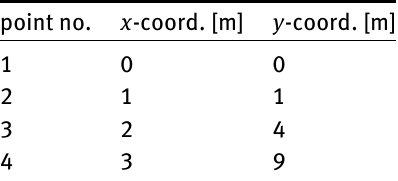
Table 1: Example dataset for straight line fitting in 2D point no.